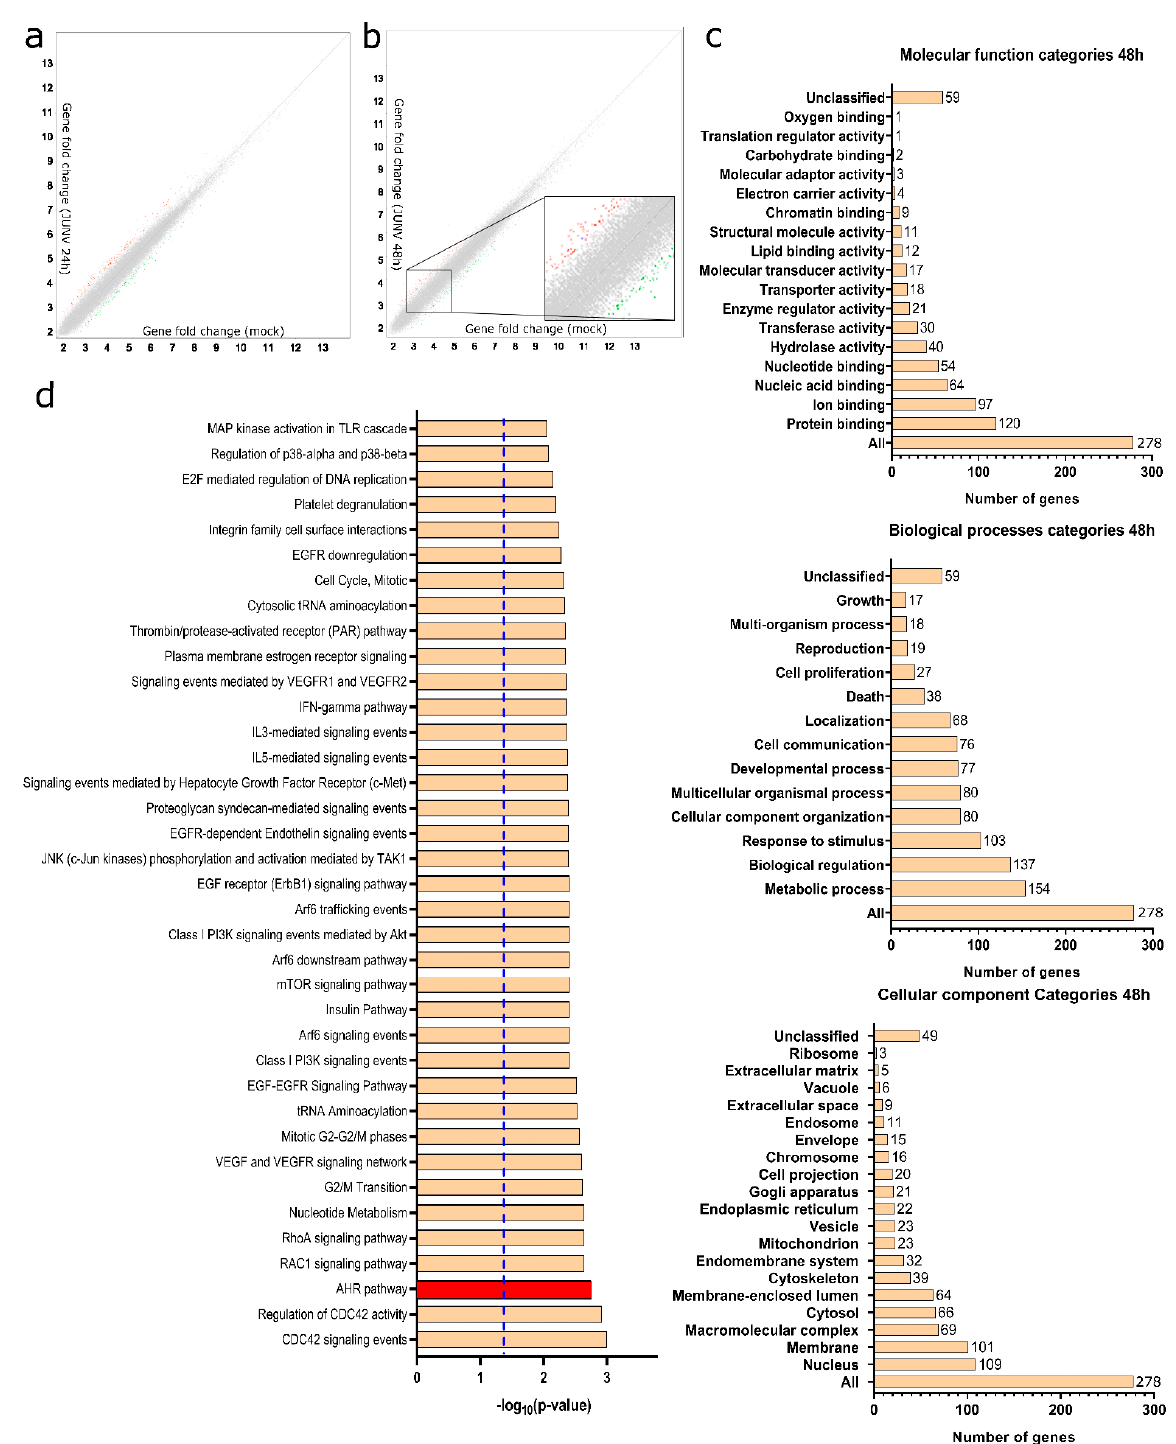
Figure 1. Differential gene expression assessment of JUNV-infected HepG2 cells: ( a ) Differentially expressed genes between mock-infected and JUNV-infected HepG2 cells at 24 h pi identified by Affymetrix microarray assay ( n = 3 independent experiments per condition). Host genes showing at least a 1.6-fold change in expression and a 95% probability of being expressed differentially ( p =